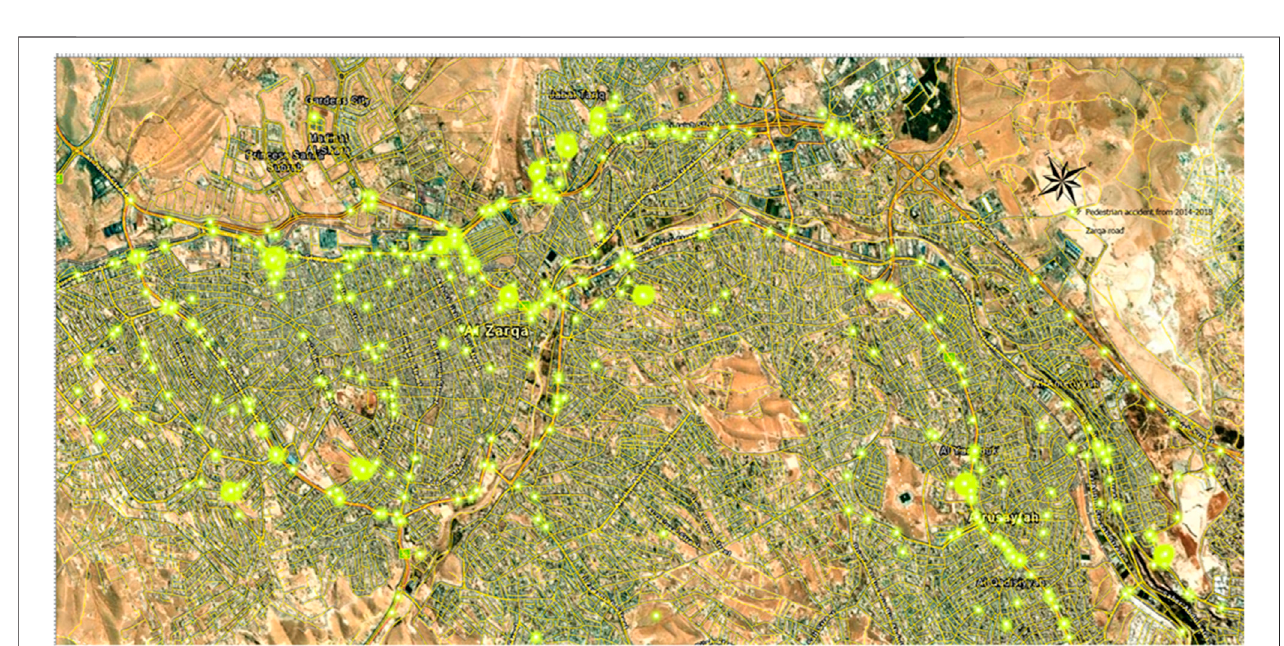
FIGURE 10 | Pedestrian crashes for Zarqa City in 2014 –